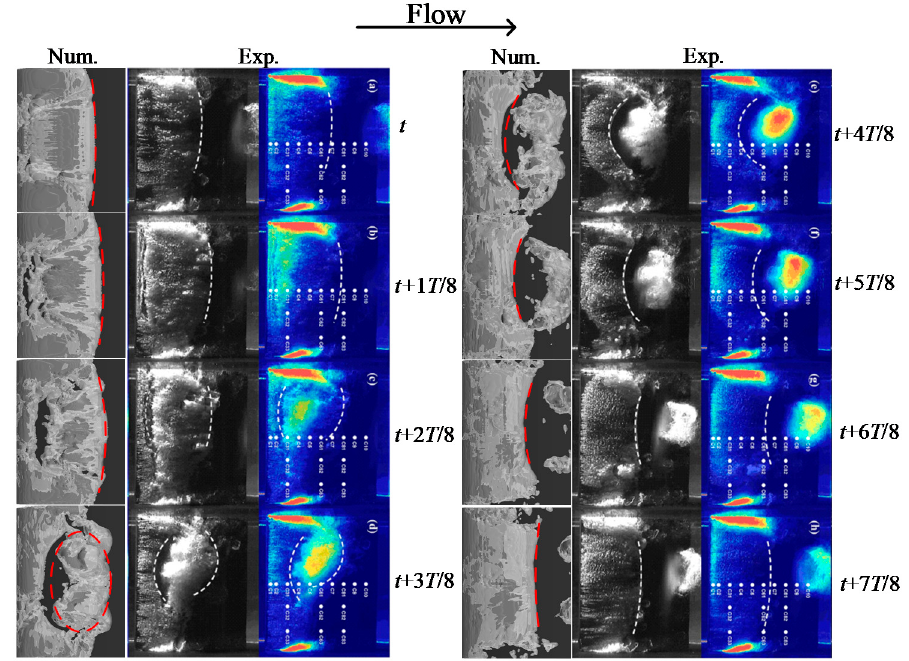
Figure 5. Numerically predicted cavity evolution compared with experimental results [16].